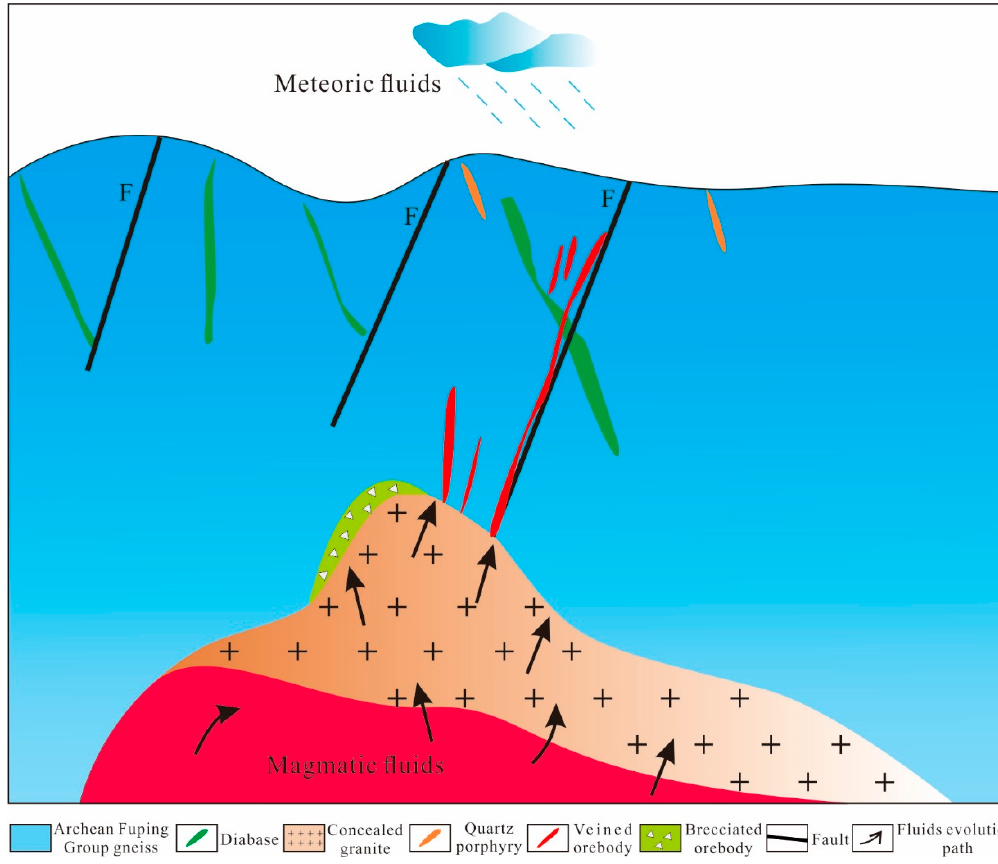
Figure 15. Schematic diagram illustrating the proposed genetic model for the Liyuan gold